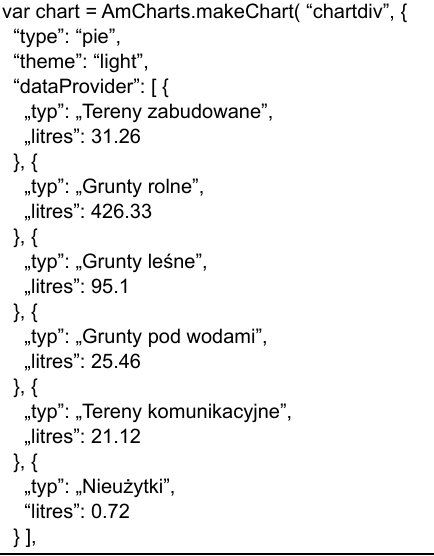
Table 5. AmChart data array (JavaScript code) var chart = AmCharts.makeChart( “chartdiv”, { “type”: “pie”, “theme”: “light”, “dataProvider”: [ {